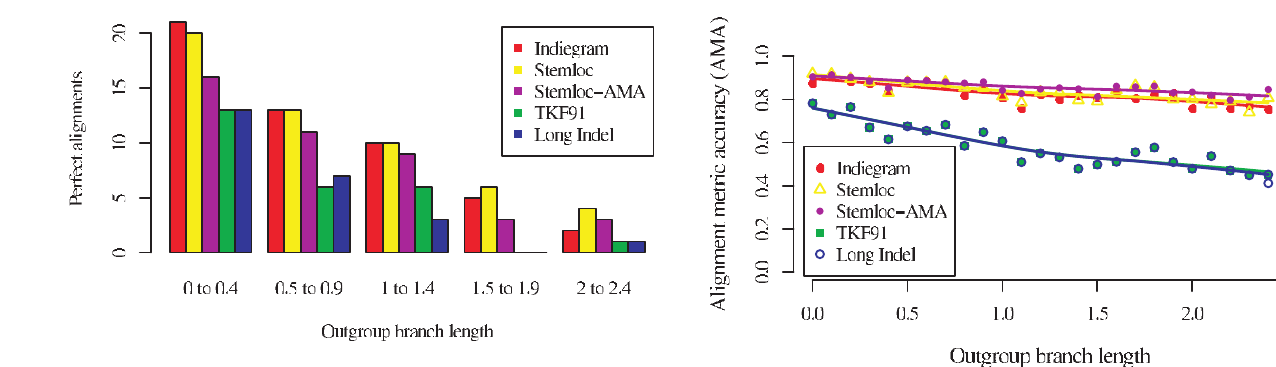
Figure 11. Dependence of alignment metric accuracy on alignment method and outgroup branch length. We simulated the evolution of three structural RNAs under the TKFST model. The simulation included two sister species at unit distance from the ancestral sequence, plus one ‘‘outgroup’’ whose branch length t was varied between ½ 0,2 : 5 (cid:1) by selecting 25 equally spaced values of t in this range, spaced 0 : 1 apart. We then simulated 25 alignments for each value of t , using TKFST model parameters described in the text. The Alignment Metric Accuracy (AMA) is, roughly, the proportion of residues that are correctly aligned, averaged over all pairs of sequences (see [54] for a precise definition; we set the AMA Gap Factor to 1). The AMA between the true alignment and the inferred alignment was measured for various statistical alignment inference procedures. These procedures are described in the text, but may be summarized very briefly as ML under the true model (‘‘Indiegram’’); greedy approximate-ML progres- sive alignment by single-linkage clustering with pair SCFGs (‘‘Stemloc’’); sequence annealing, a form of posterior decoding to maximize a sum- over-pairs accuracy metric, using pair SCFGs to get the posterior probabilities (‘‘Stemloc-AMA’’); statistical alignment using the TKF91 model, i.e. linear gap-penalties (‘‘TKF91’’); and statistical alignment using a long-indel model, i.e. affine gap-penalties (‘‘Long Indel’’).